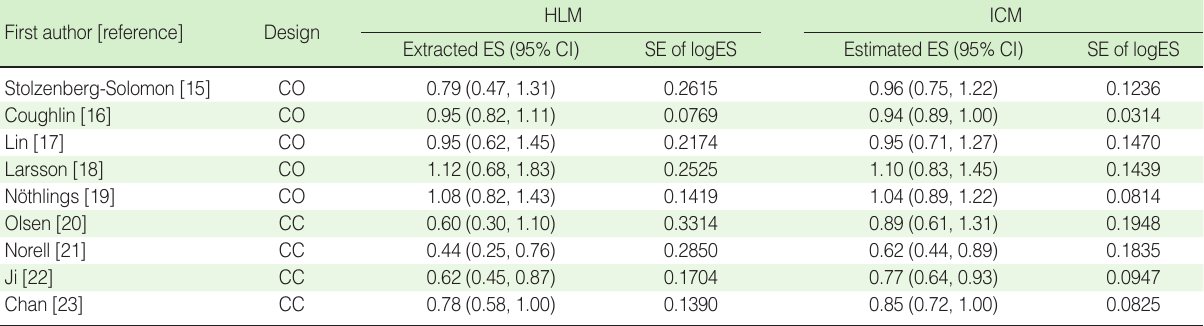
Table 2. The effect size (ES) and 95% confidence intervals (CI) obtained by using the two extracting methods: “highest versus lowest in- take” method (HLM) and interval collapsing method